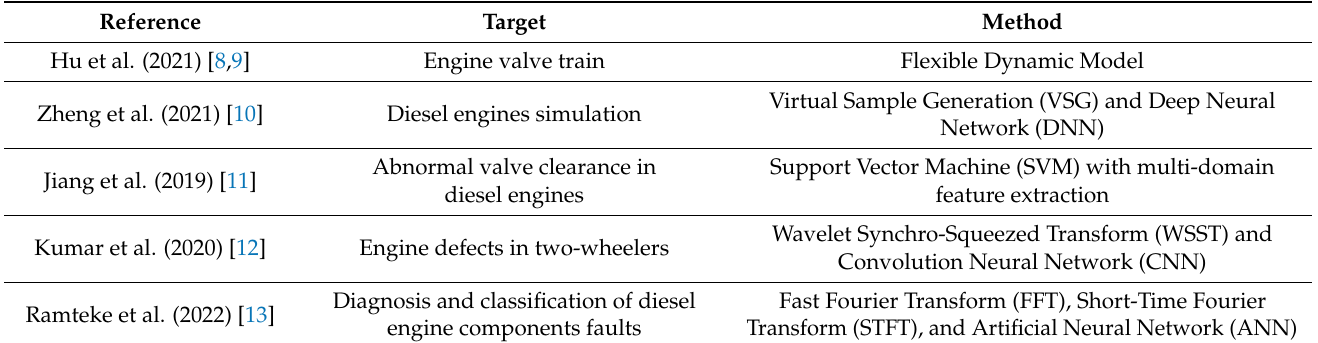
Table 1. The targets and methods of related works.